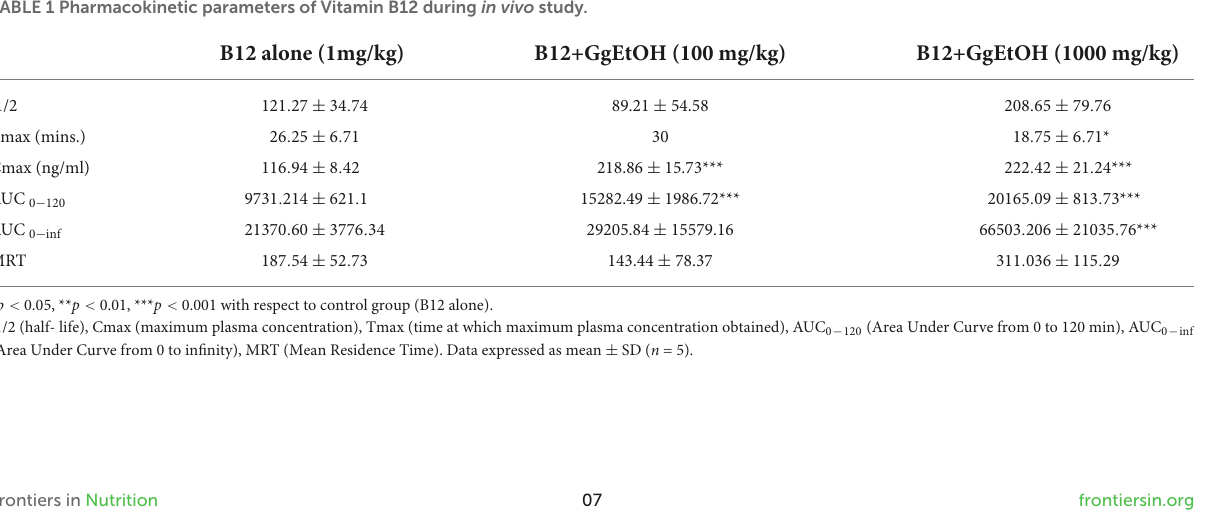
TABLE 1 Pharmacokinetic parameters of Vitamin B12 during in vivo